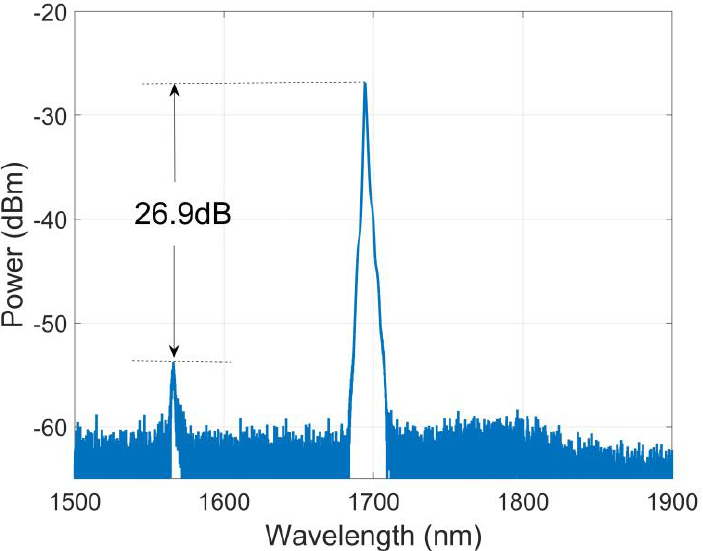
Figure 5. The optical spectrum indicates high optical spectral purity.